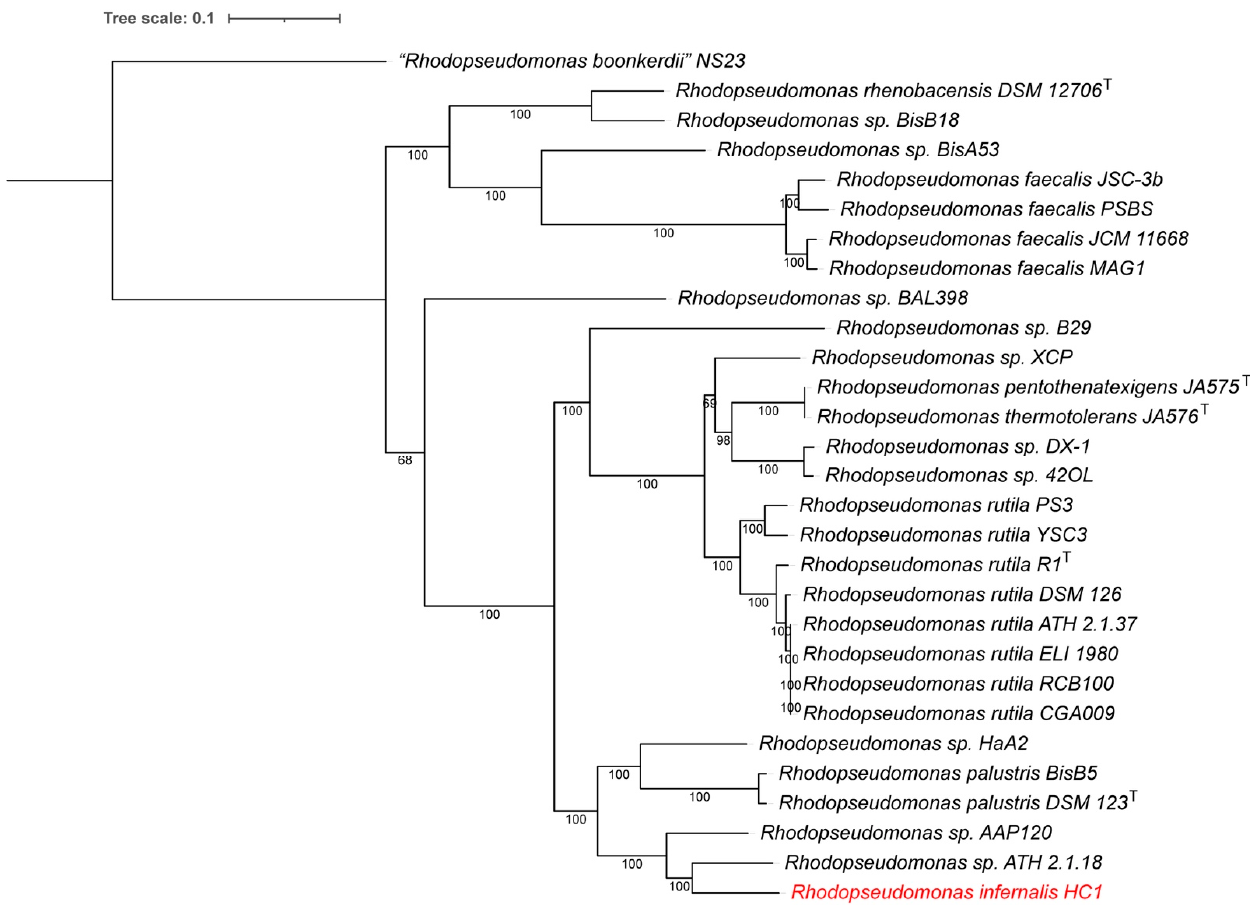
Figure 2. Whole genome ‐ based phylogenetic tree of all sequenced Rhodopseudomonas strains. The phylogenetic tree was generated using the codon tree method within PATRIC. The tree is rooted at midpoint. The Rhodopseudomonas isolate from Hell Creek (HC1) is indicated in red.